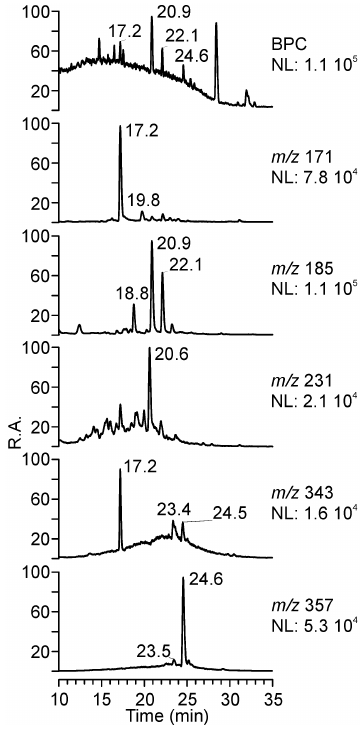
Fig. 2. LC/MS chromatographic data (BPC and EICs) for fine am- bient aerosol (PM 2 . 5 ) from K-puszta, Hungary, collected during the night of 19 June 2006 of the warm period of the 2006 summer field campaign. The peak at RT 22.1min (not discussed in the main text) on the m/z 185EIC is tentatively assigned to cis -caronic acid, a po- sitional isomer of cis -pinic acid, based on comparison of its chro- matographic properties with literature data (Larsen et al.,